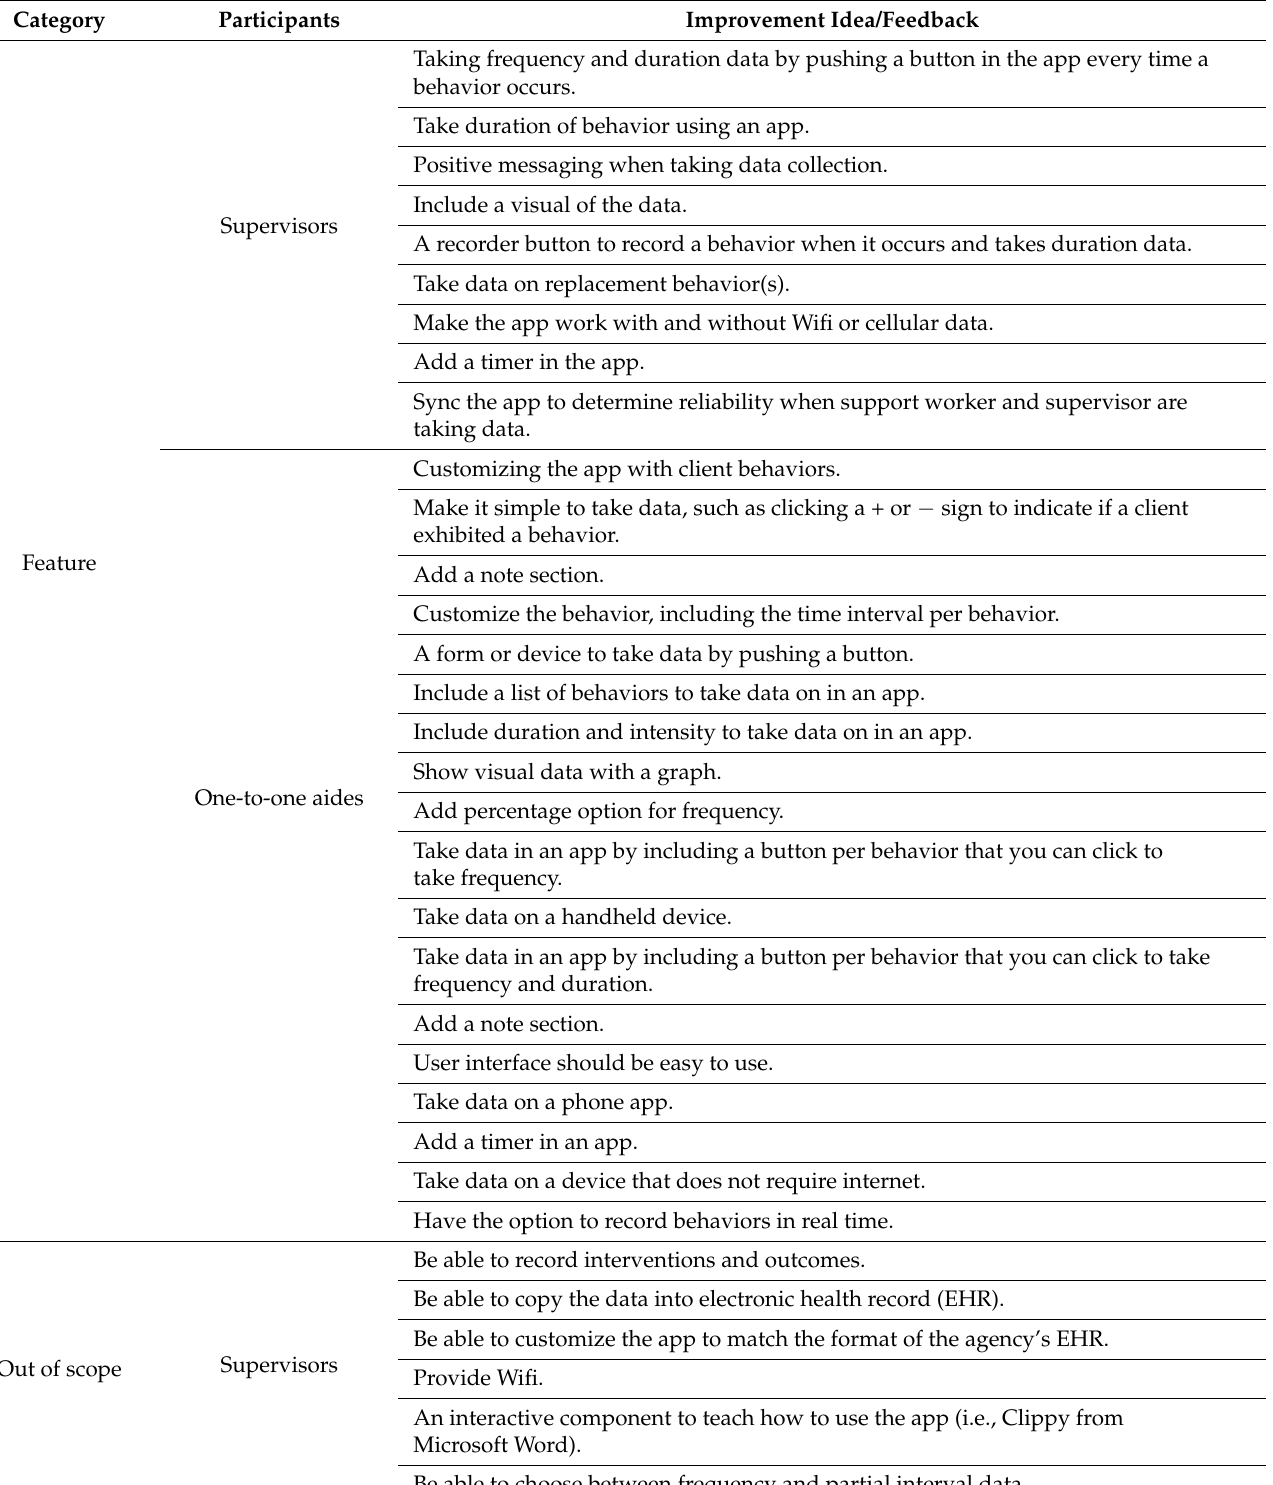
Table 3. App improvement ideas: